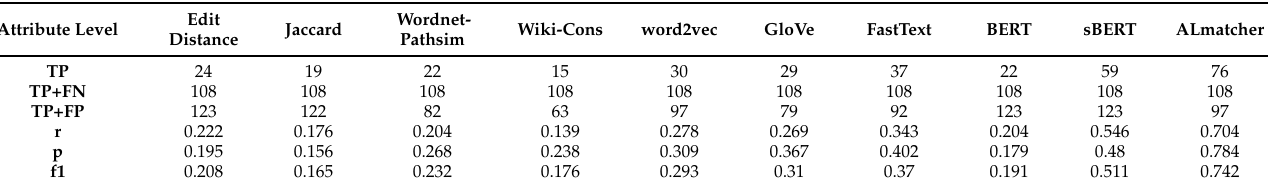
Table 8. Evaluation of attribute-level matching